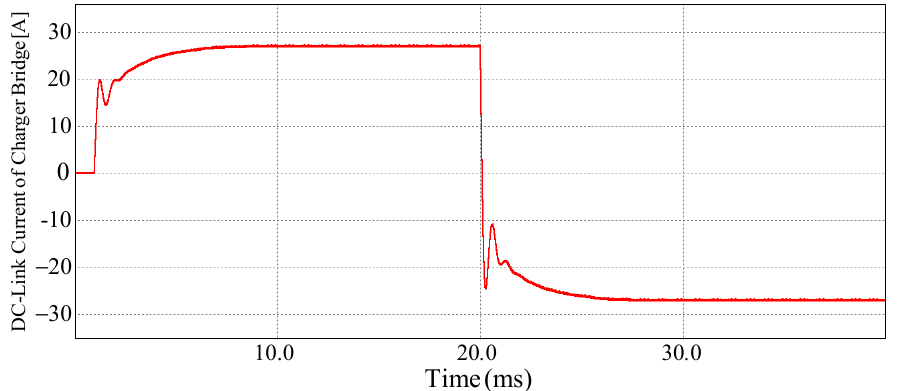
Figure 9. Direct current (DC)-link current of EV active bridge under power flow direction change at t = 20 ms at with τ 1 = 10 µs and τ 2 = 1 µs.